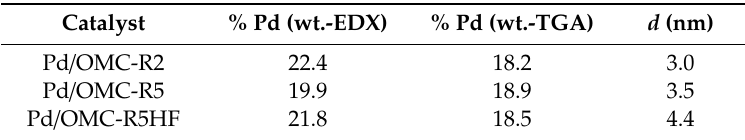
Table 3. Metal loading by EDX, TGA and crystal size by XRD of Pd / OMC